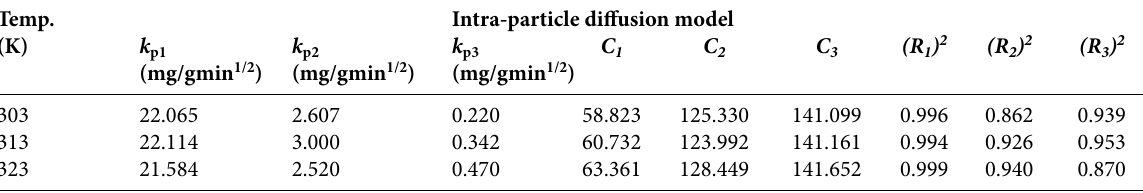
Fig. 6. Plots of intra-particle diffusion model for the adsorption of MB dye onto SA-RPB at 203; 313 and 323 Table 4. Intra-particle diffusion model constant for MB adsorption by SA-RPB at different temperatures Temp.